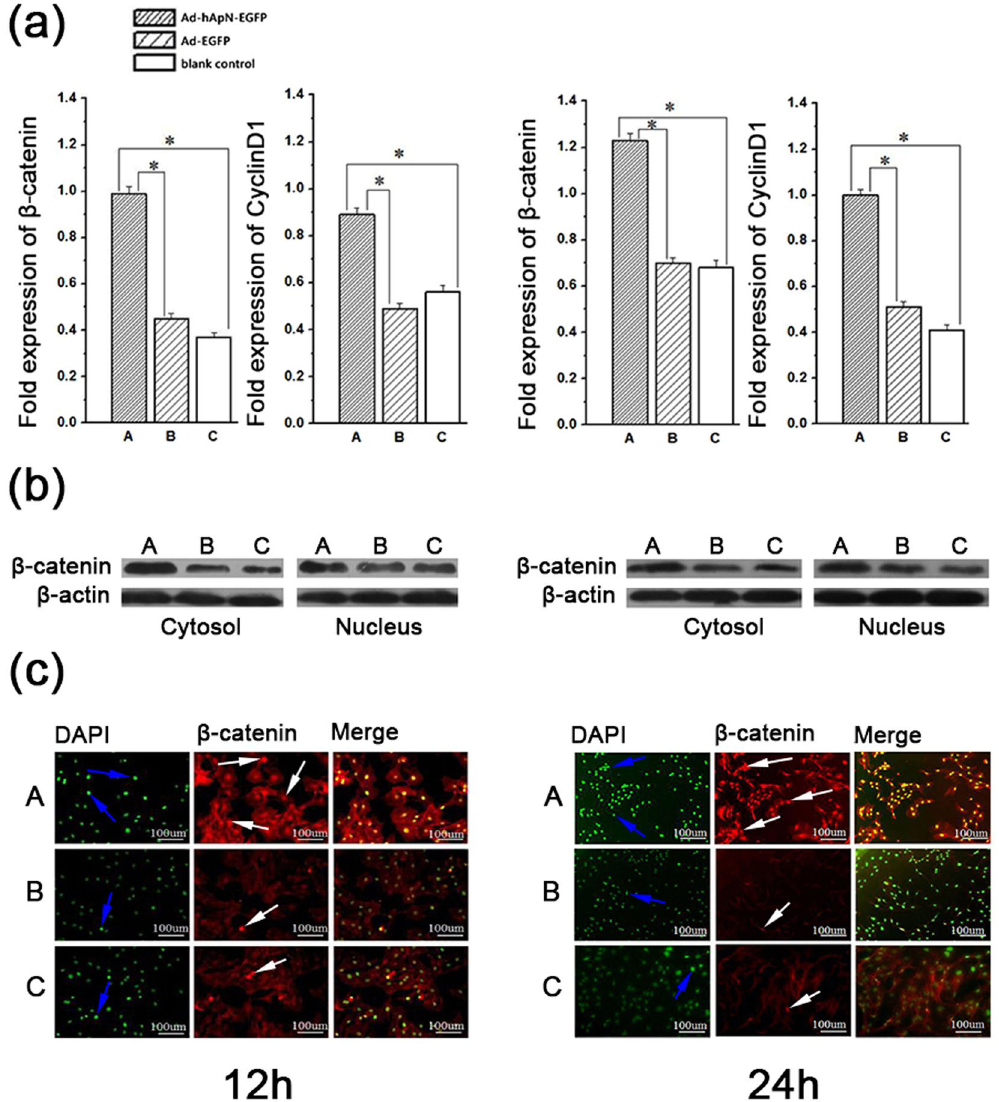
Figure 5. Gene and protein expressions of Wnt/ β -catenin pathway related factors in BMSCs after osteogenic induction for 12 h (left side of Figure 5) and 24 h (right side). ( a ) Gene expressions of β -catenin and cyclinD1 by real-time PCR. Both genes were signifcantly elevated in group A (Ad-hApN-EGFP). * P < 0.05. ( b ) Protein expressions of β -catenin and cyclinD1 by western blotting. The two genes were up-regulated in group A both in cytoplasm and nucleus, and more β -catenin translocated into nucleus. ( c ) Immunofluorescence staining of BMSCs. Nucleus was stained with DAPI (blue arrow). The β -catenin (white arrow) expressed in both cytoplasm and nucleus and the fluorescent density and intensity were higher in group